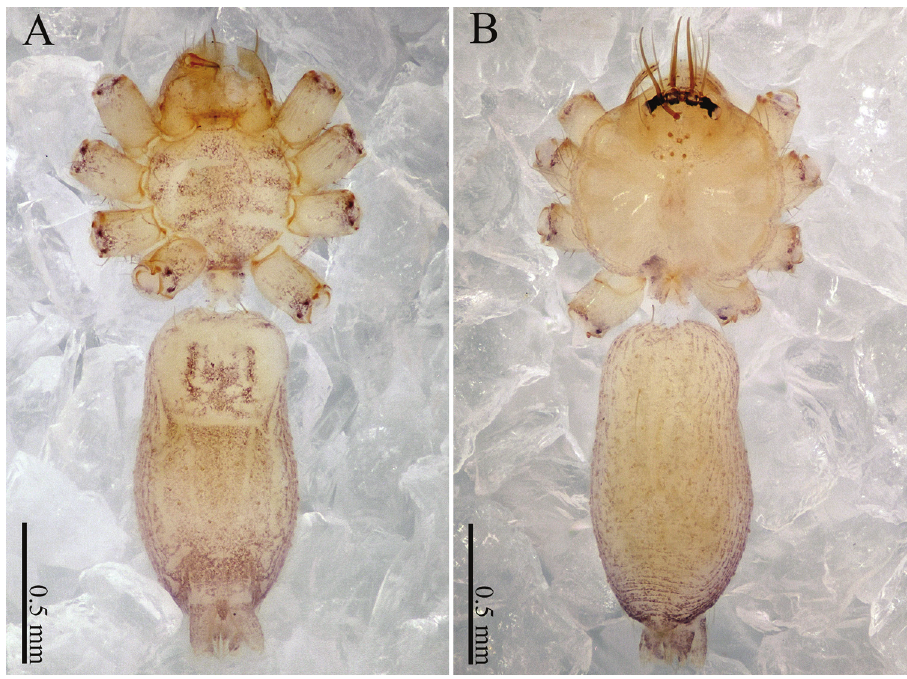
Figure 18. Sinoderces saraburiensis Li & Li, sp. nov., male holotype A male habitus, ventral view B male habitus, dorsal